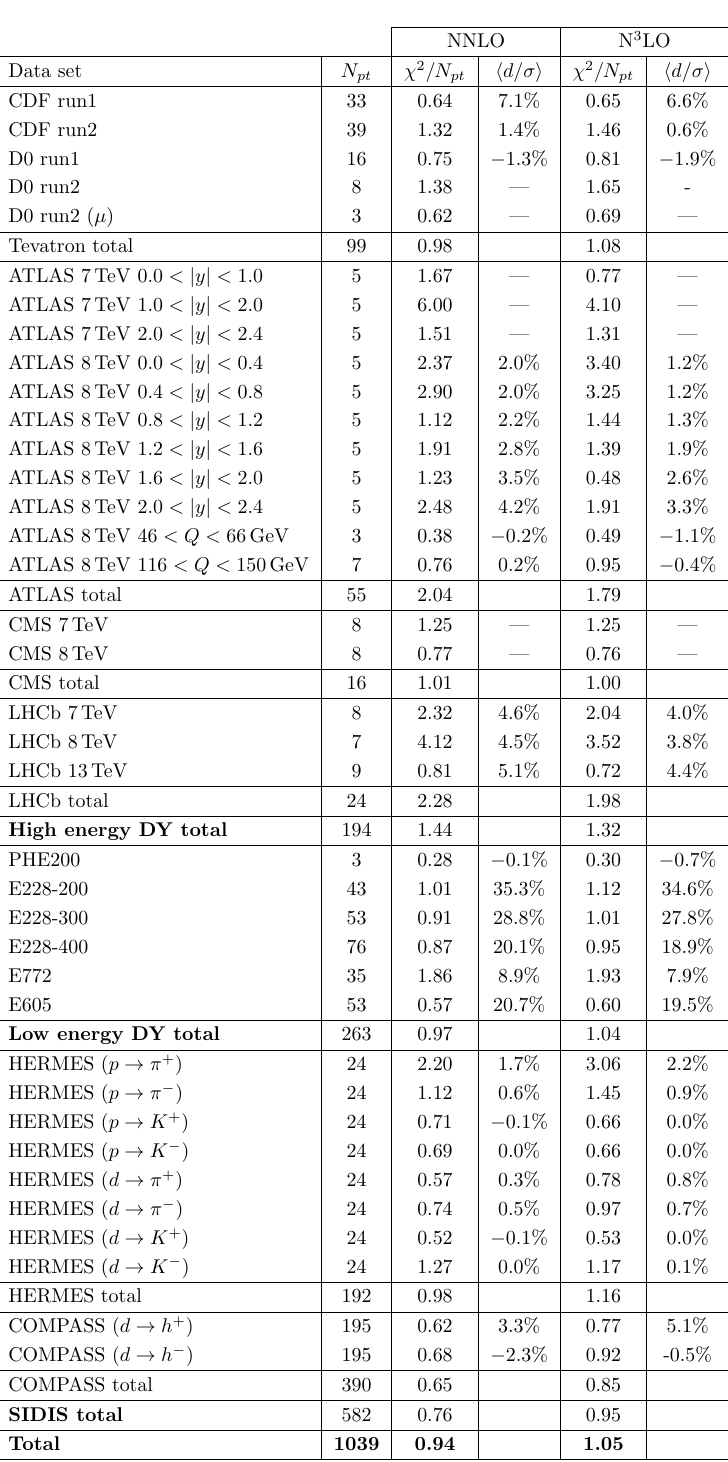
Table 8 . Distribution of the values of (cid:31) 2 over data set in the global (cid:12)t of SIDIS and DY. The column h d=(cid:27) i report the average normalization de(cid:12)cit of the cross-section (multiplicity) as de(cid:12)ned in (4.18).